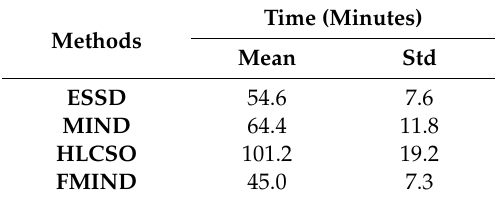
Table 4. Computation time for all evaluated methods operating on the 3D CT–MR image pairs.